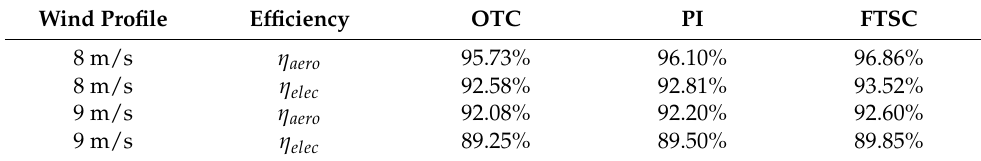
Table 3. Power extraction efficiency